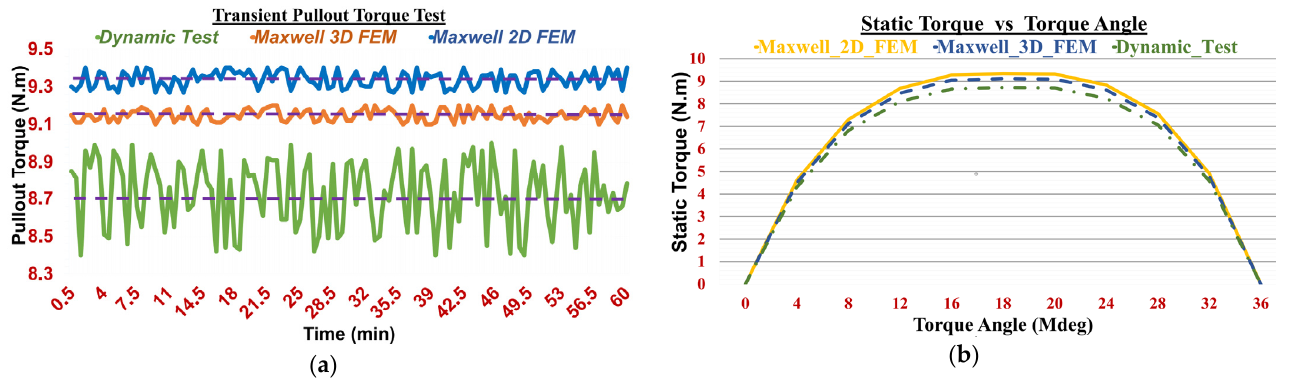
Figure 25. Test results of the optimum MC in the 10-pole, 0.98-embrace, and 10 mm length configuration: ( a ) Pullout torque in transients; ( b ) Static torque versus torque angle in magnetostatics.